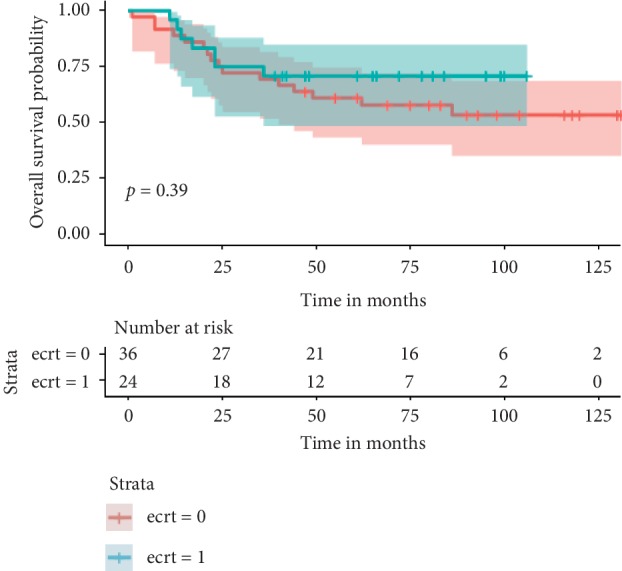
Kaplan‐Meier curves showing overall survival stratified by use of reimplantation. Green line with reimplantation of tumor bone and the red without. Time is in months.